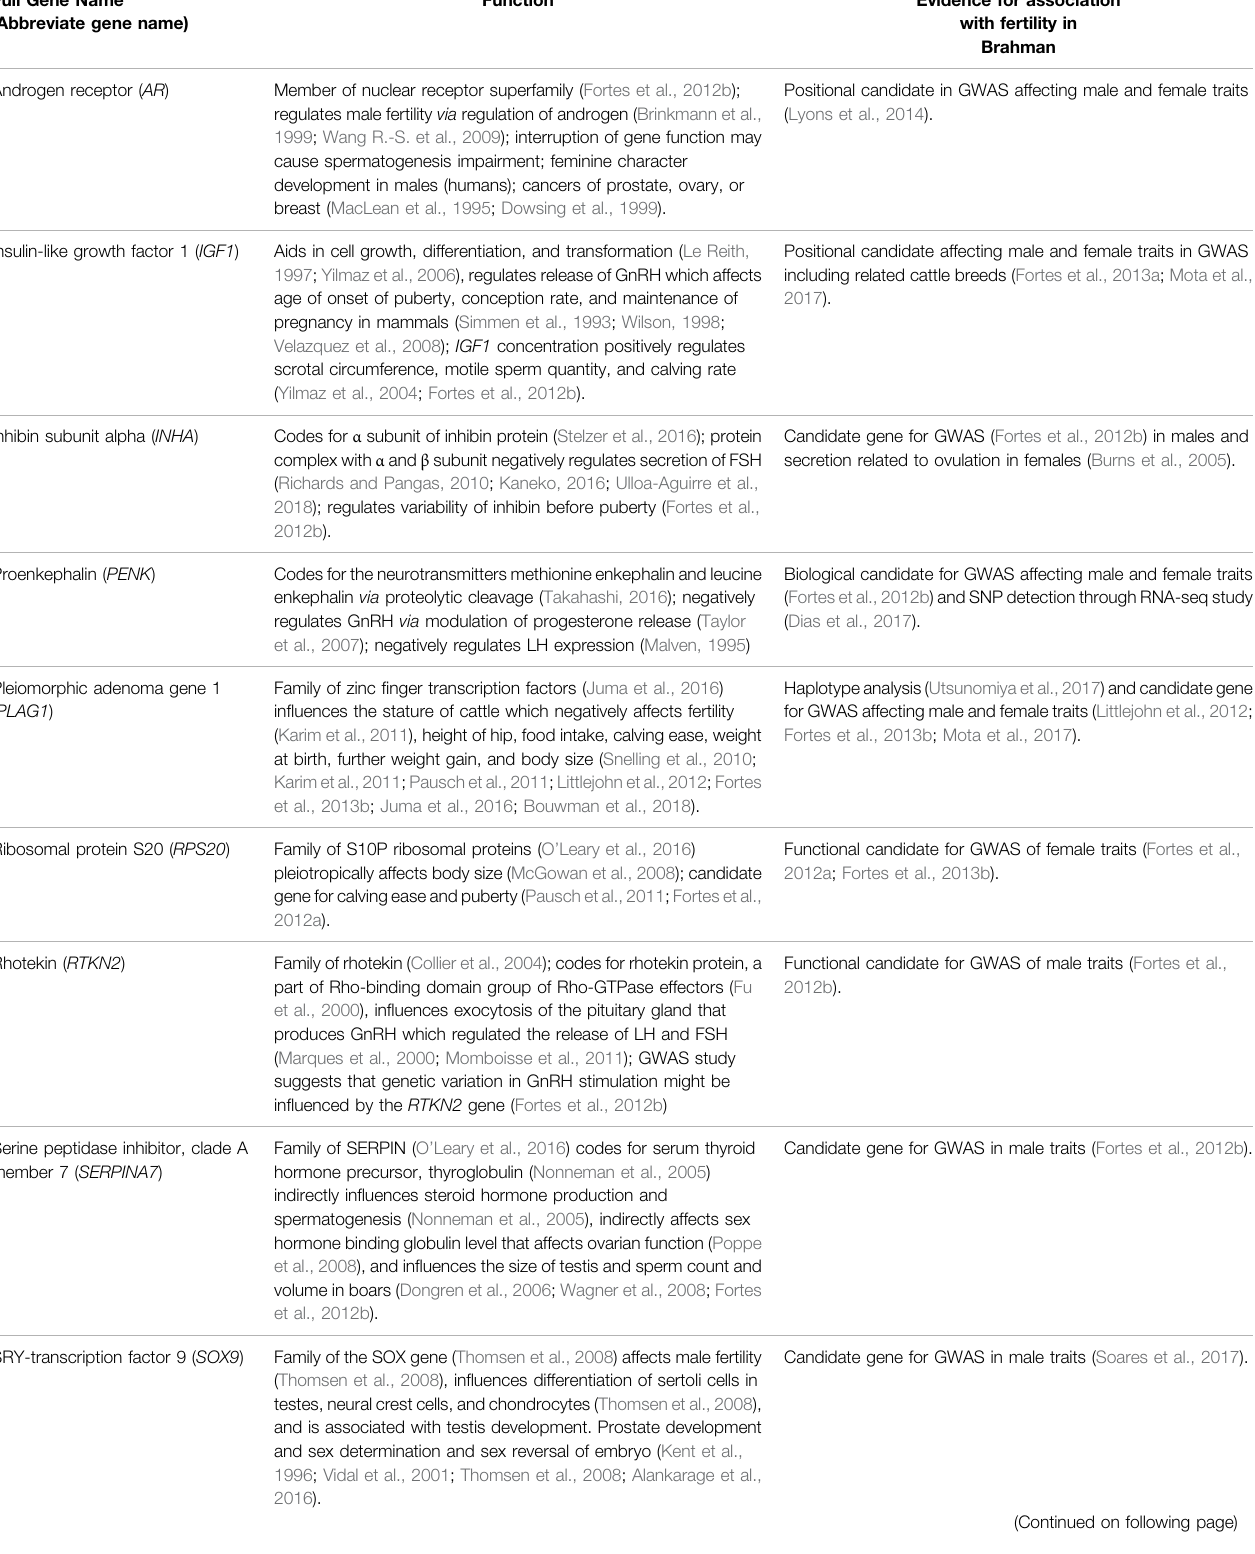
TABLE 1 | Genes (identi fi ed from literature) as involved in Brahman